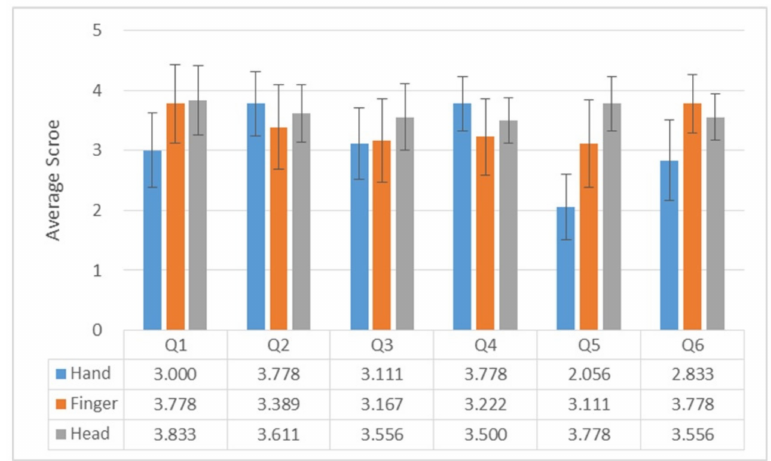
Figure 11. Average score of questionnaires for each interaction ( +/ - standard deviation of the